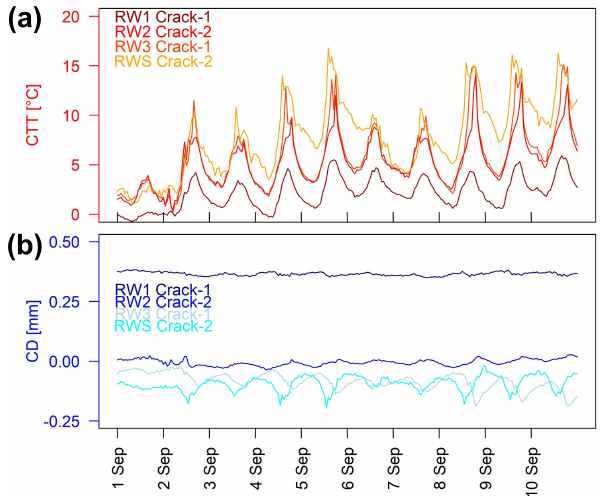
Figure 8. (a) Crack-top temperature and (b) crack deformation for selected crackmeters of RW1, RW2, RW3 and RWS between 1 September 2018 and 10 September